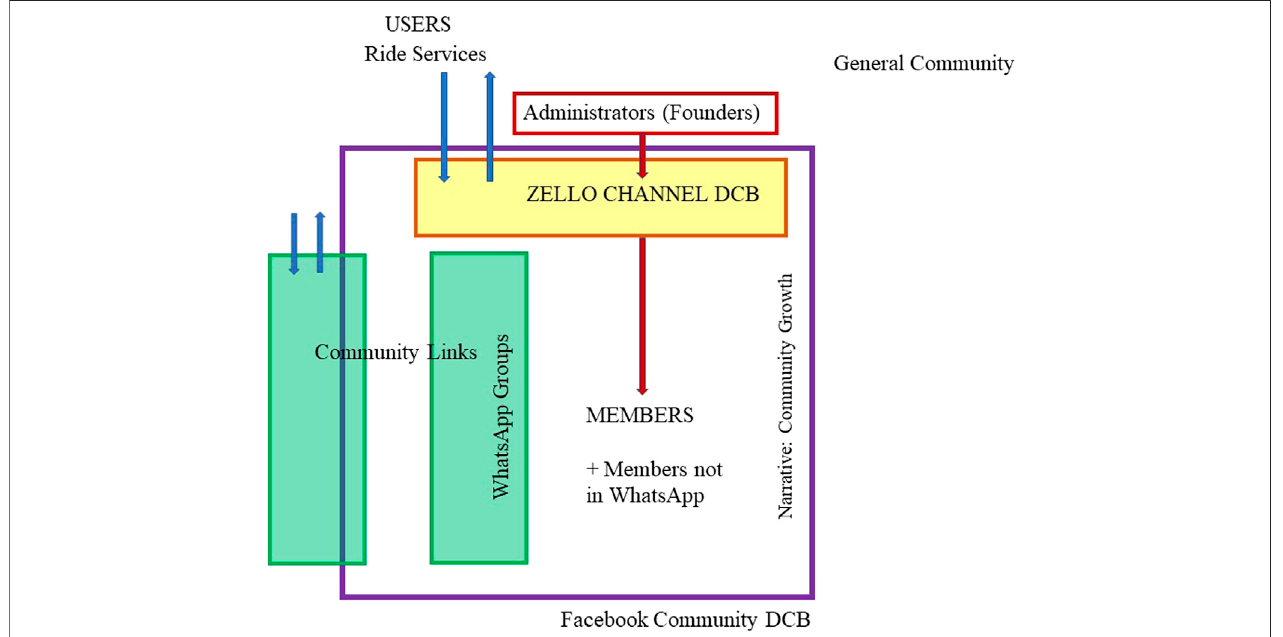
FIGURE 3 | Driver ’ s club Bogotá current hierarchy source: elaborated by the author.